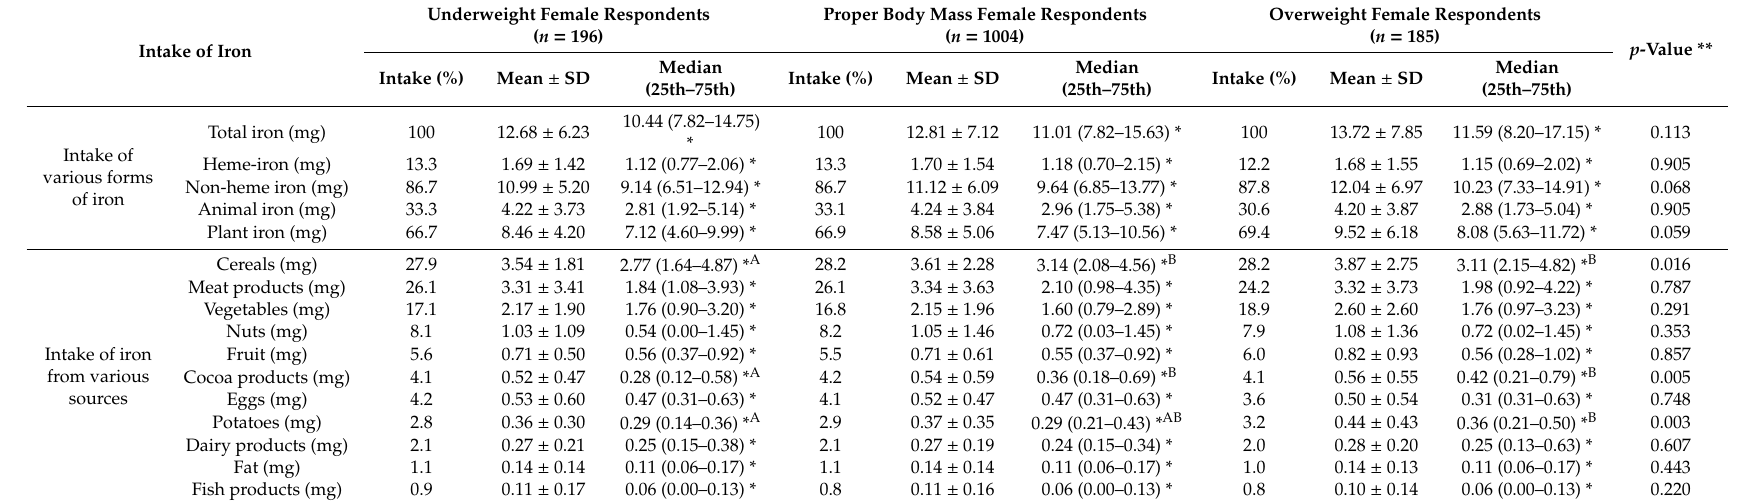
Table 4. Comparison of the intake of various forms of iron along with that of iron intake from various sources in the national sample of Polish female adolescents, in the sub-groups of underweight, proper body mass, and overweight female